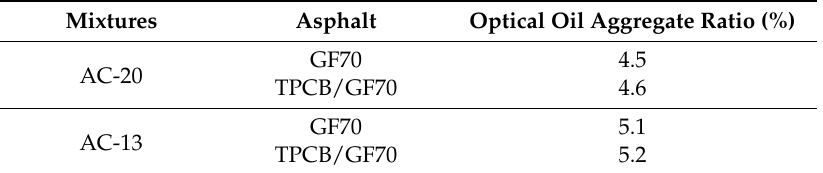
Table 8. Optical oil aggregate ratio of GF70 and TPCB/GF70 asphalt